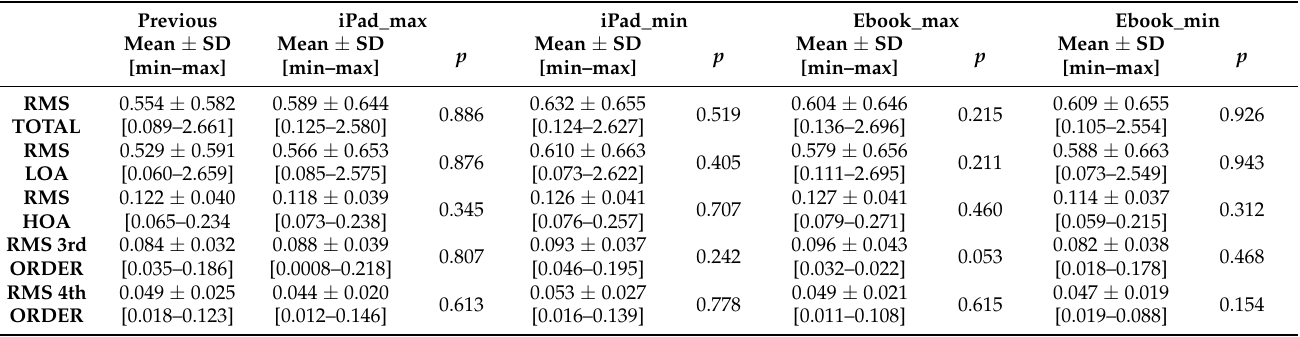
Table 1. Aberrometry values; mean ± standard deviation ( ± SD) in µ m. No statistical differences were found between measurements ( p >